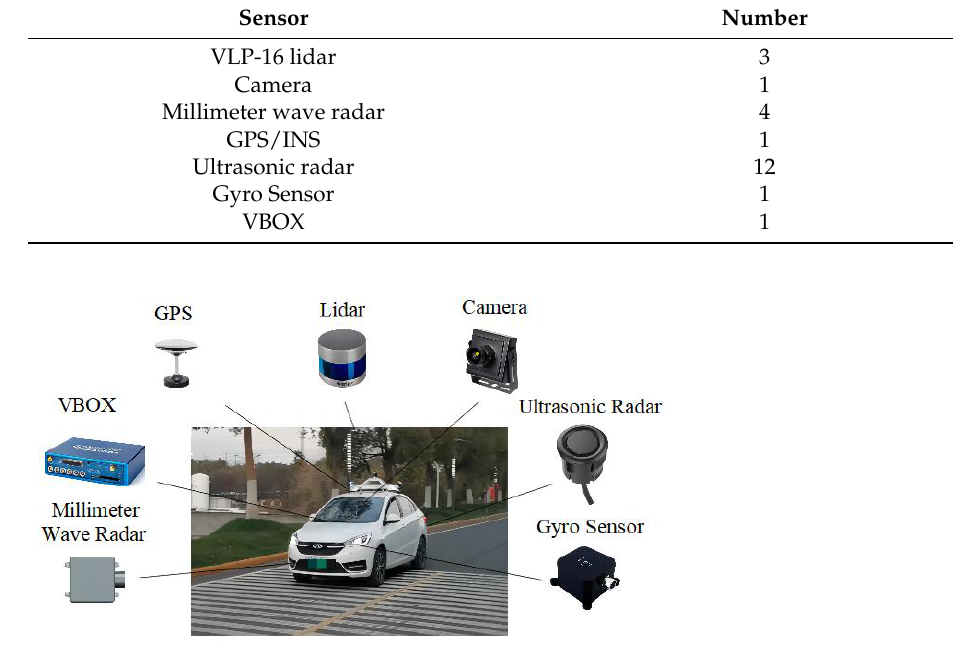
Figure 9. Experimental Figure 11. Experimental platform. Table 1. Configuration of sensors.